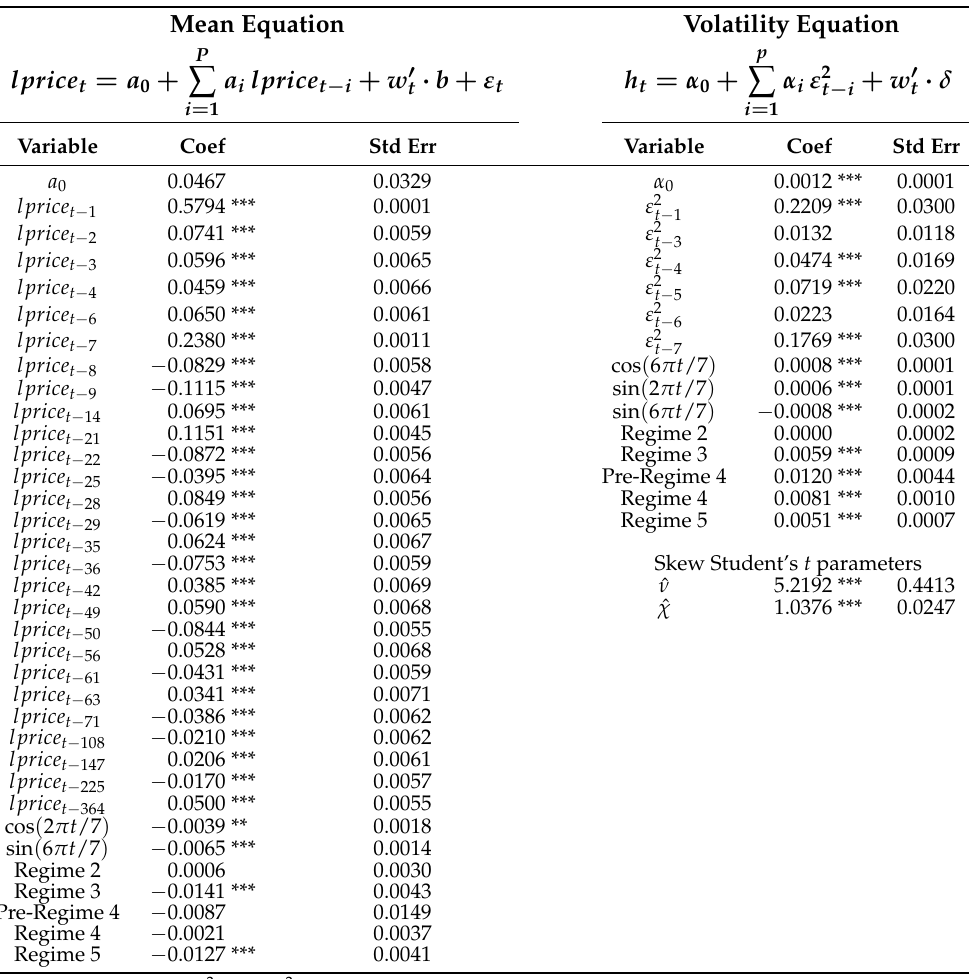
Table A4. Estimation results when assuming skew Student’s t